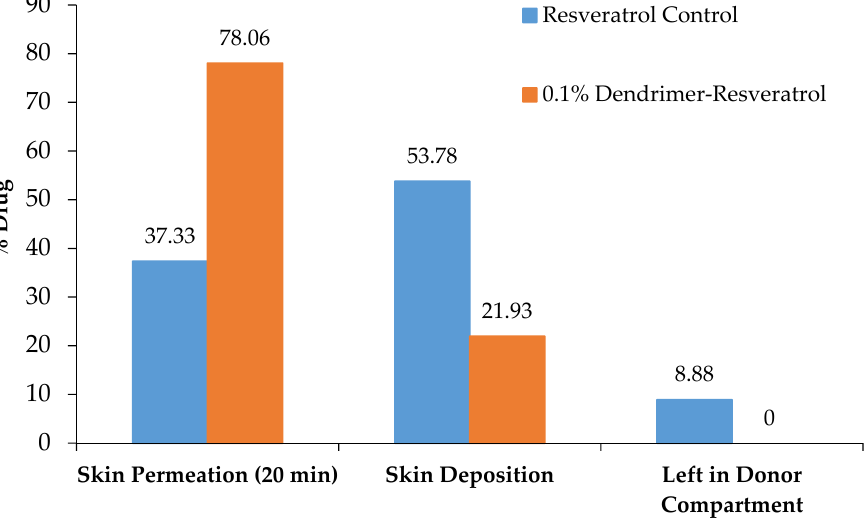
Figure 6. Transdermal Permeation of RSV formulations.